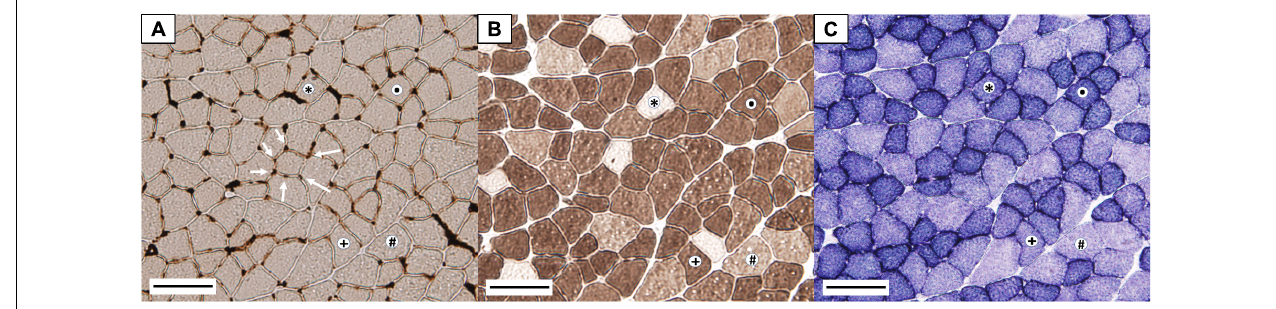
FIGURE 1 | Representative microphotographs of gastrocnemius cross-section histochemical assays. (A) Endothelial ATPase stain (arrows indicate muscle capillaries); (B) myosin ATPase stain; (C) succinate dehydrogenase stain. ( ∗ ) Slow oxidative fiber (SO); ( · ) fast oxidative glycolytic fiber (FOG); (+) fast intermediate glycolytic fiber (FIG); # fast glycolytic fiber (FG). Bar represents 100 µ